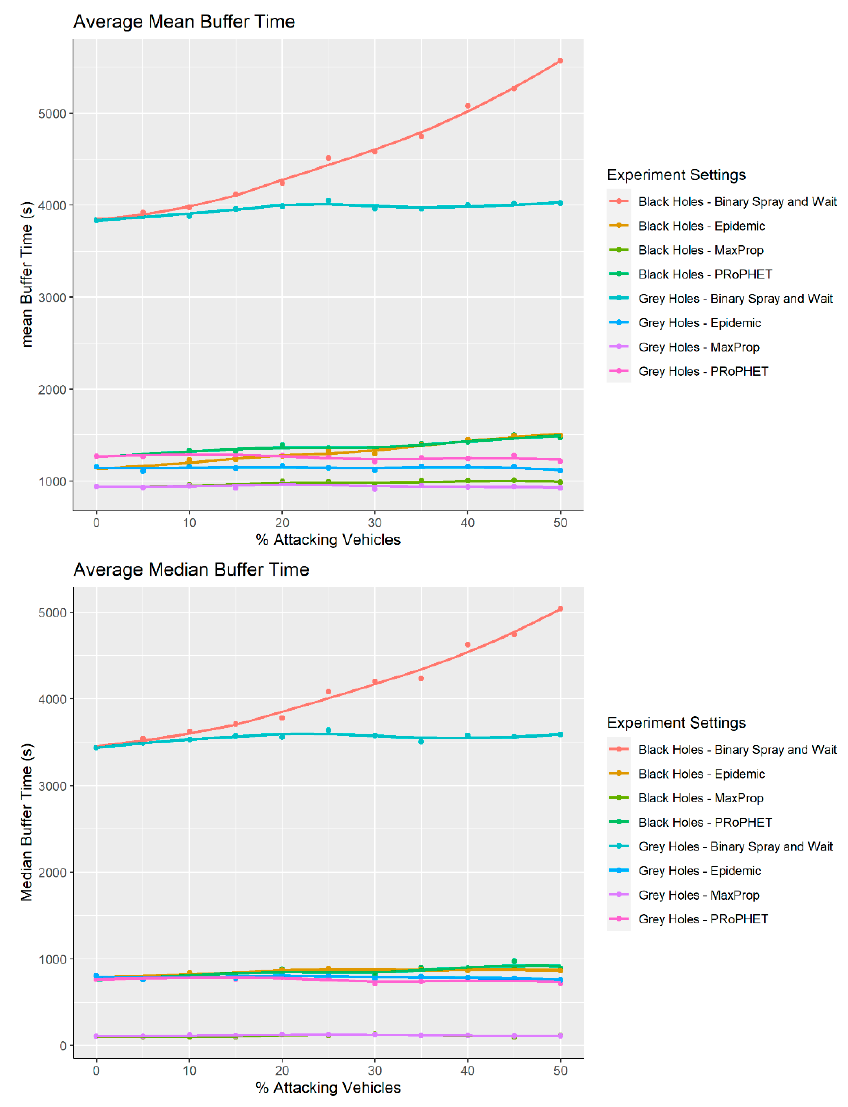
Figure 9. Two averages for the buffer times throughout the experiment.